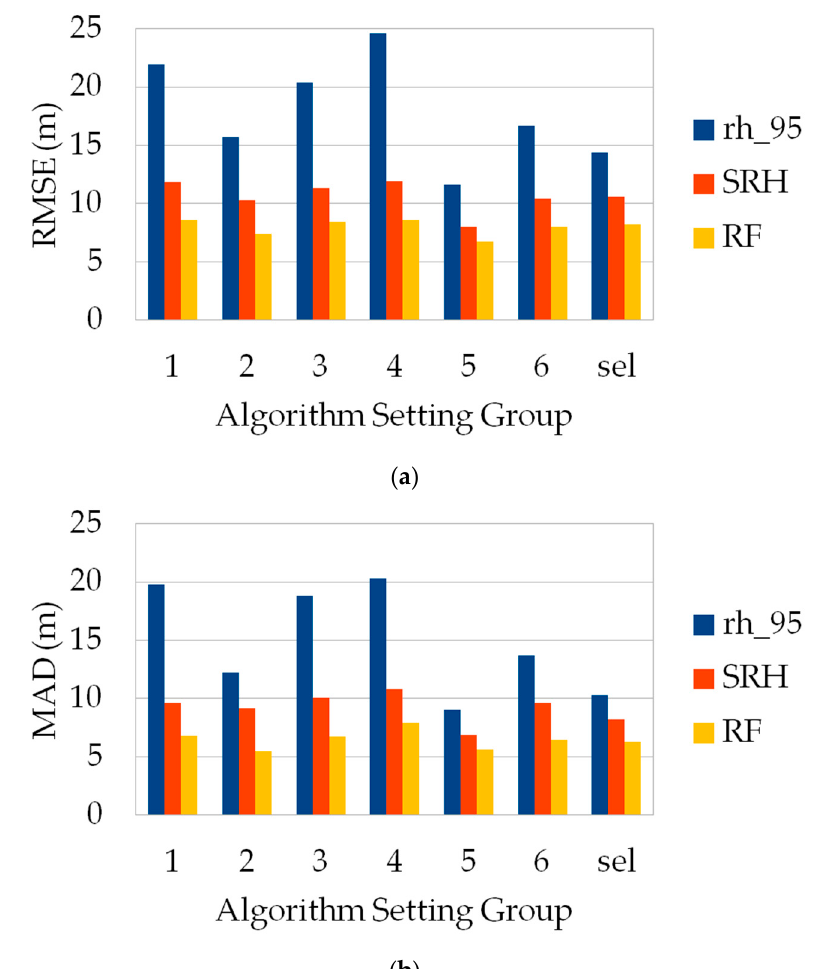
Figure 7. RMSE ( a ) and MAD ( b ) for GEDI-CHM estimators (10-fold cross validation, whole dataset) depending on algorithm setting group: direct estimation, SRH and RF. “sel” corresponds to GEDI-selected algorithm.